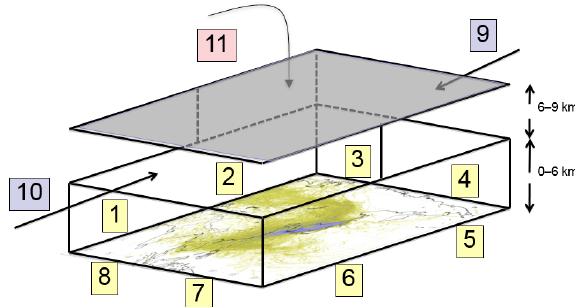
Figure 2. Schematic of the domain borders as applied in the in- version. A total of 11 domain border conditions were estimated as depicted from 1 to 11 as a multiplying factor to the prior base- line estimated using data from the Mace Head observatory. Be- low 6km, the domain border was divided eight times: NNE, ENE, ESE, SSE, SSW, WSW, WNW, and NNW; between 6 and 9km, the domain border was just divided between north and south; and air arriving from above 9km was considered from one “high” do- main border. Average posterior multiplying factors for CF 4 over the 8 years were 1 . 00 ± 0 . 01 (NNE), 0 . 97 ± 0 . 06 (ENE), 1 . 02 ± 0 . 05 (ESE), 0 . 99 ± 0 . 01 (SSE), 1 . 00 ± 0 . 01 (SSW), 0 . 99 ± 0 . 01 (WSW), 1 . 00 ± 0 . 00 (WNW), 1 . 00 ± 0 . 01 (NNW), 1 . 00 ± 0 . 00 (6 to 9km north), 1 . 00 ± 0 . 05 (6 to 9km south), and 0 . 97 ± 0 . 03 (above 9km).